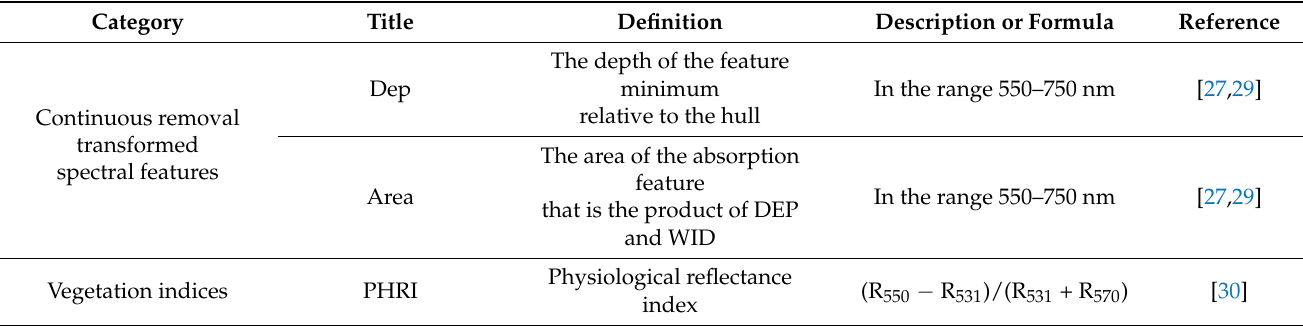
Table 1. Traditional spectral features selected in the